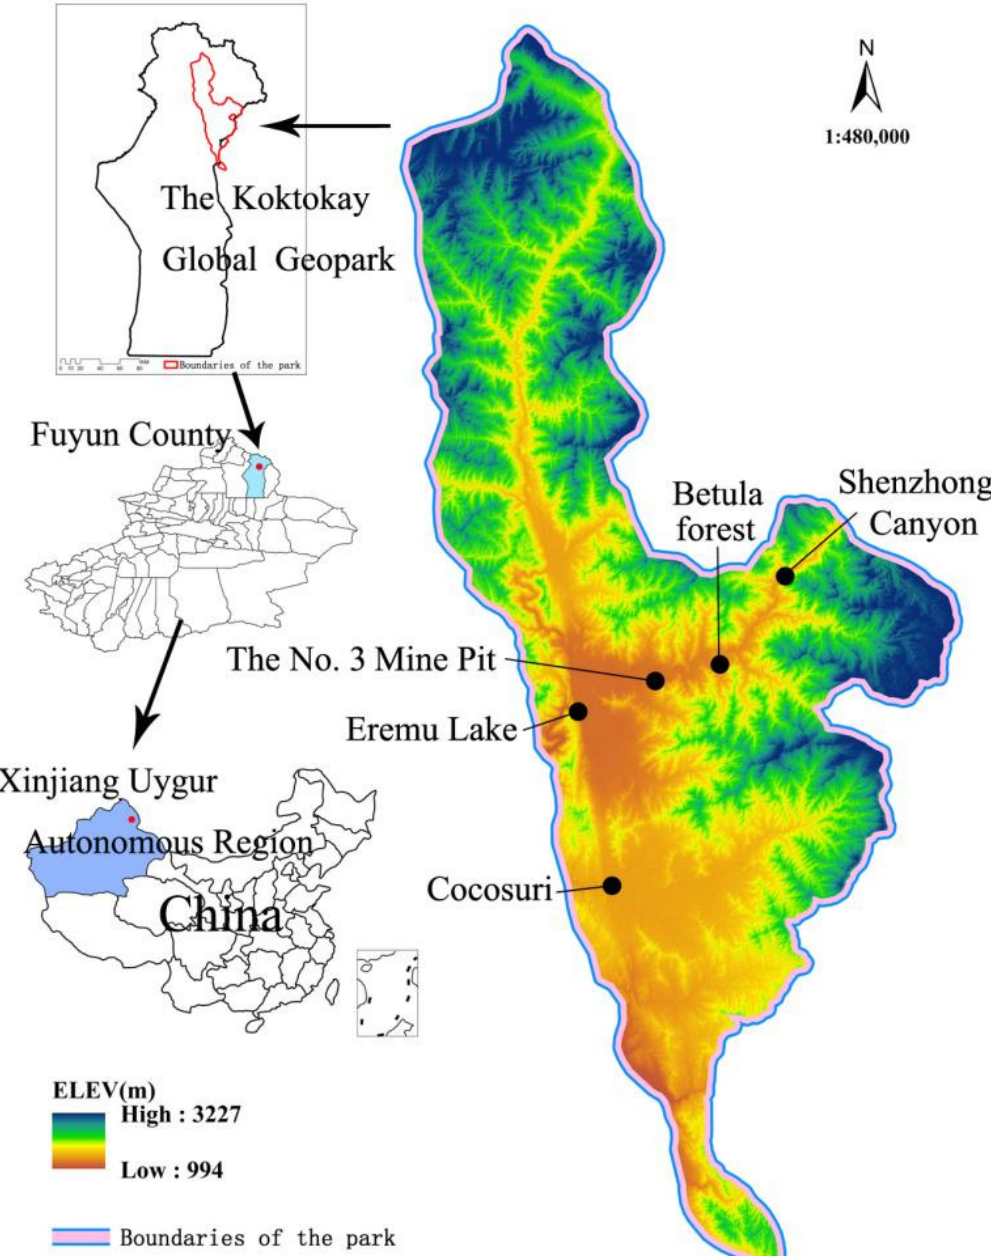
Figure 1. Map of Koktokay Global Geopark showing geological and heritage resources and elevation changes, indicating its location within northwestern China.